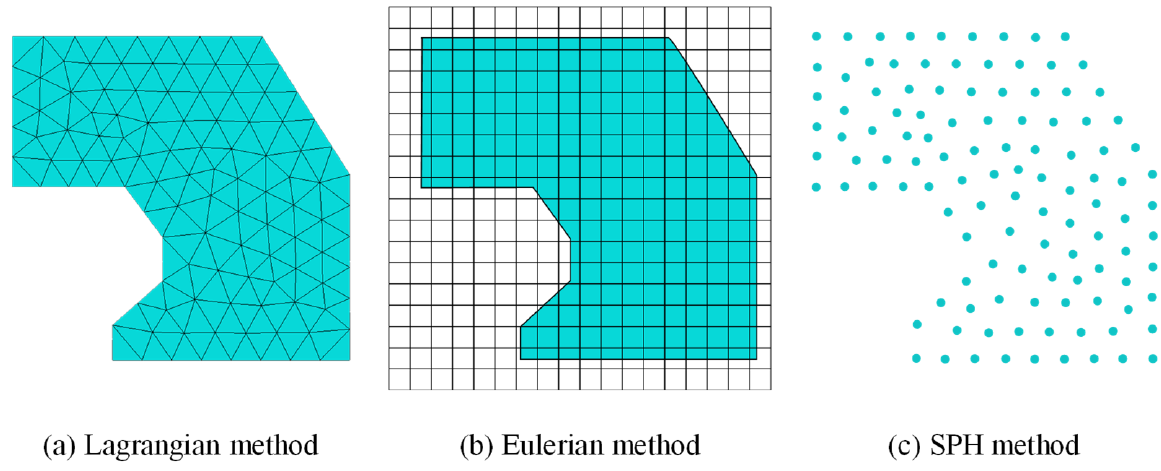
Figure 2. Comparison of different approaches.